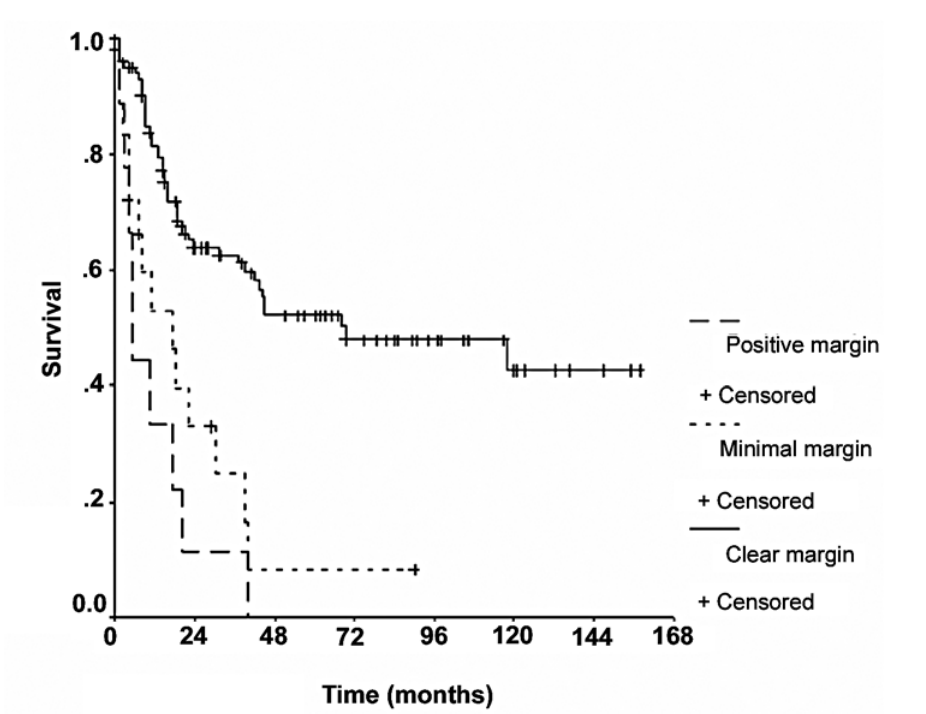
Figure 5 – Disease specific survival by surgical